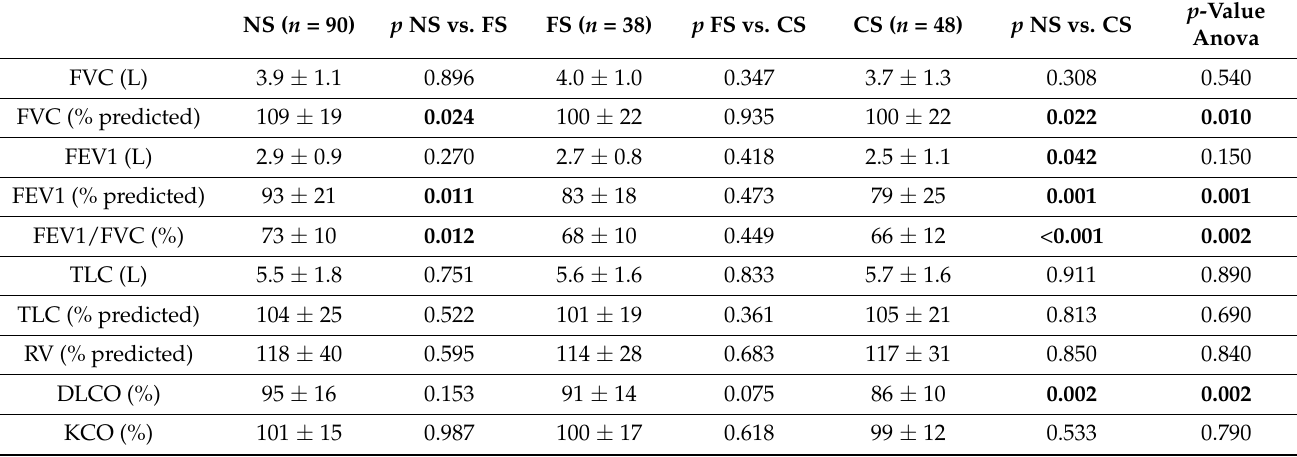
Table 2. Lung-function parameters according to smoking